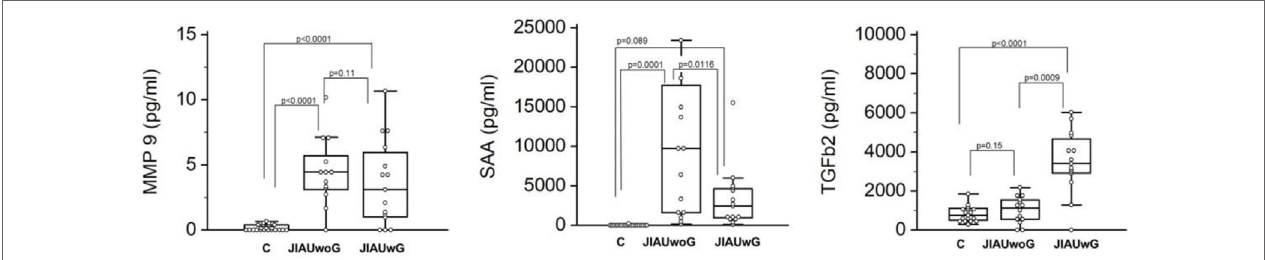
FigUre 1 | Box plots of matrix metalloproteinases (MMP)-9, serum amyloid A (SAA), and transforming growth factor beta (TGF β )-2 in patients with juvenile arthritis with (JIAUwG) or without glaucoma (JIAUwoG). Specimens collected from patients with senile cataract served as control. Dots represent individual values.